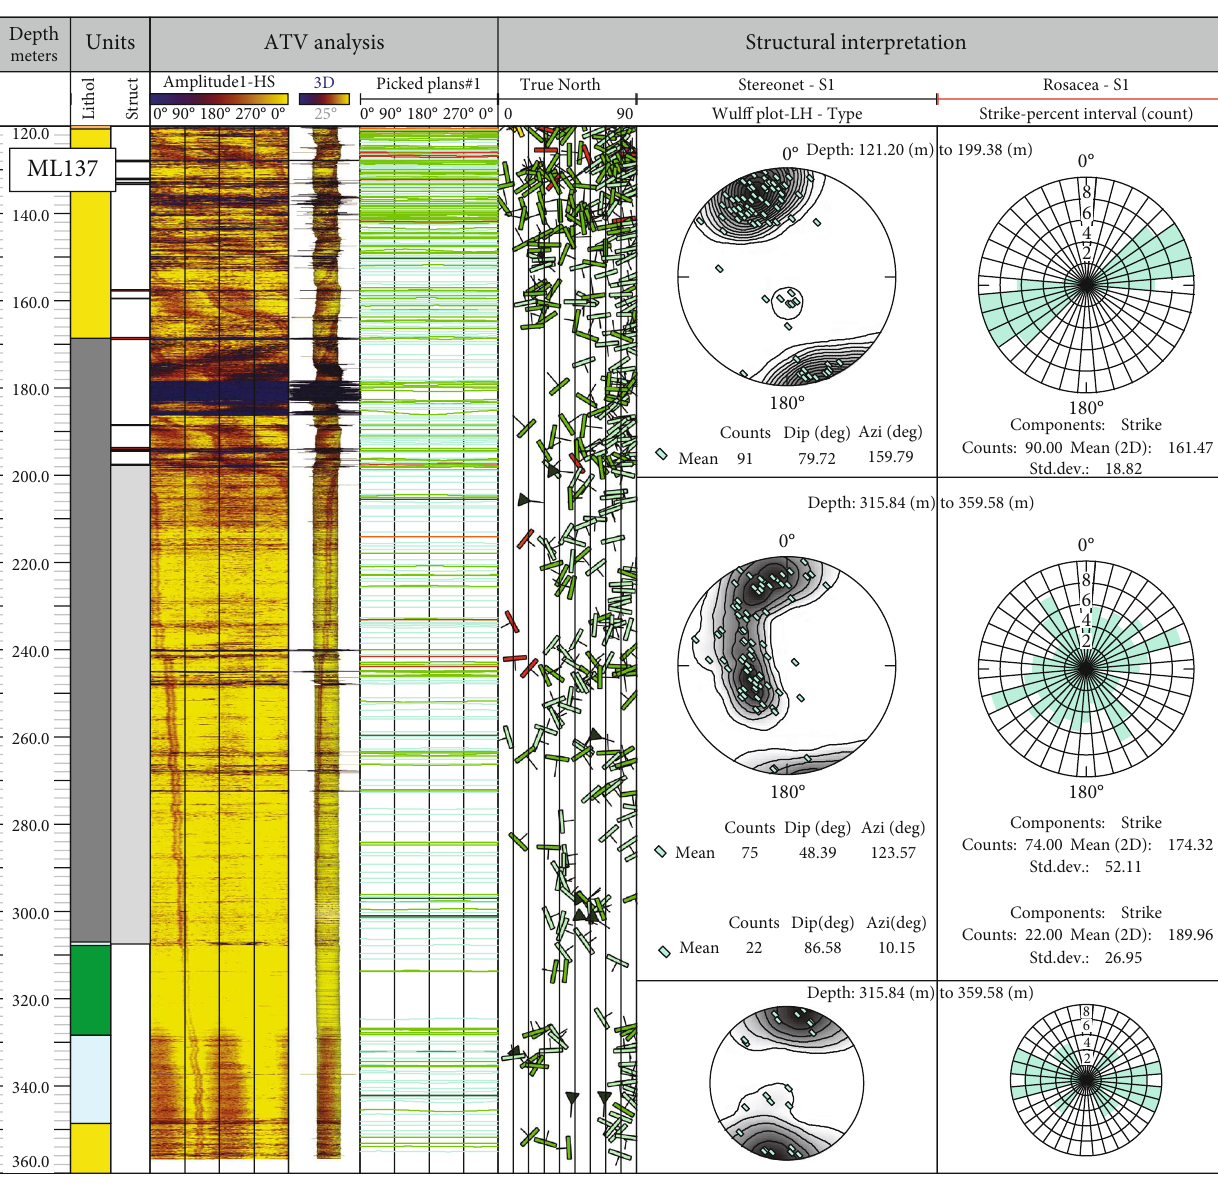
Figure 10: ATV data structural analysis from drill hole ML-137 showing the arrangement in conjugate shear zones. Note that, within the shear zone, poles span from the north to the south of the stereonets. Legend in Figure